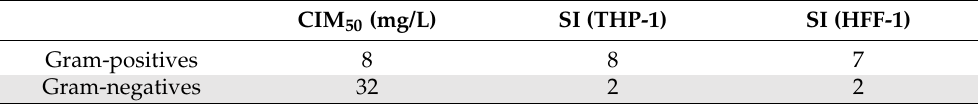
Table 3. Selectivity Index (SI) for Pln149-PEP20.